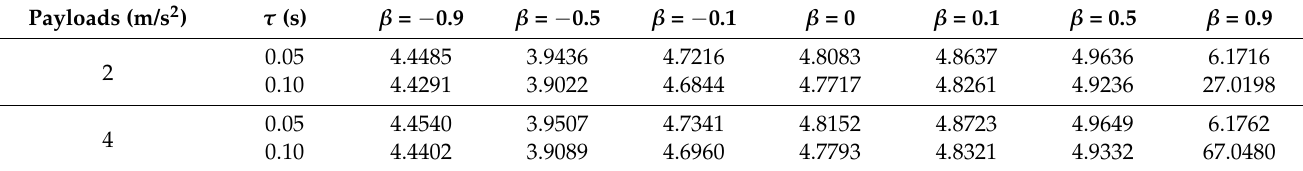
Table 16. Root mean squared value of the control signal u 3 in the first 30 s under different payloads, different input time delays and different fractional orders in the proposed